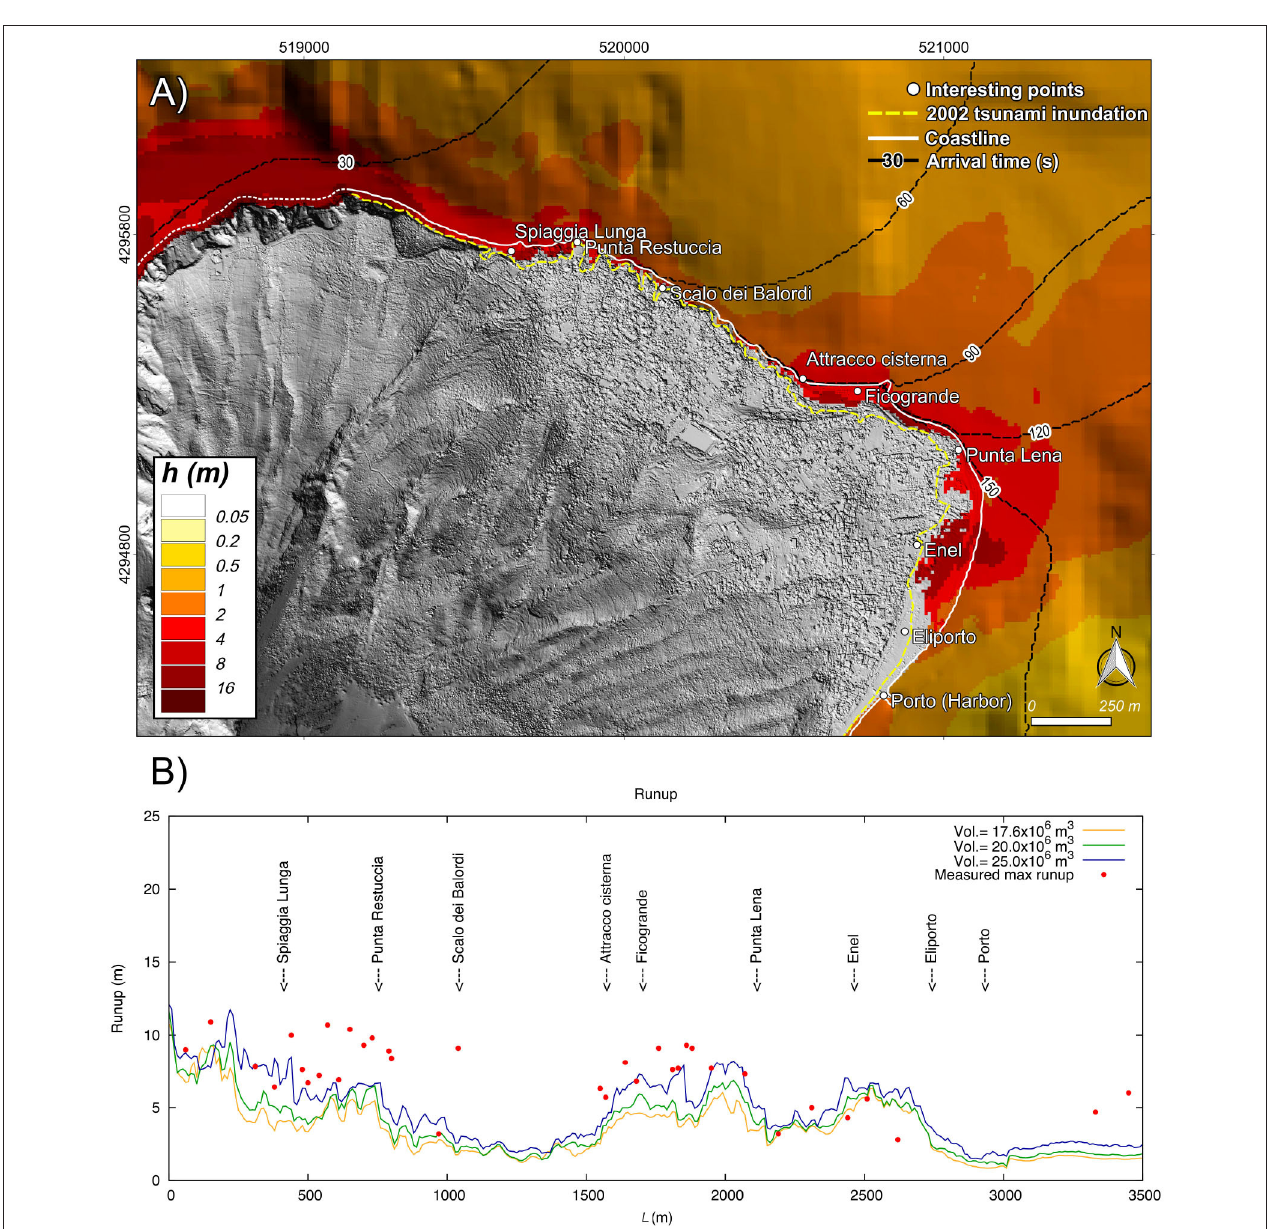
FIGURE 8 | (A) Maximum surface elevation of the tsunami generated by a submarine granular landslide of volume V = 17.6 × 10 6 m 3 . (B) Maximum runup obtained with Multilayer-HySEA and granular landslide volumes of V = 17.6,20.0, and 25.0 × 10 6 m 3 , with 3 layers. Red points represent the measurements reported by Tinti et al. (2006) of the tsunami runup for the 2002 event at